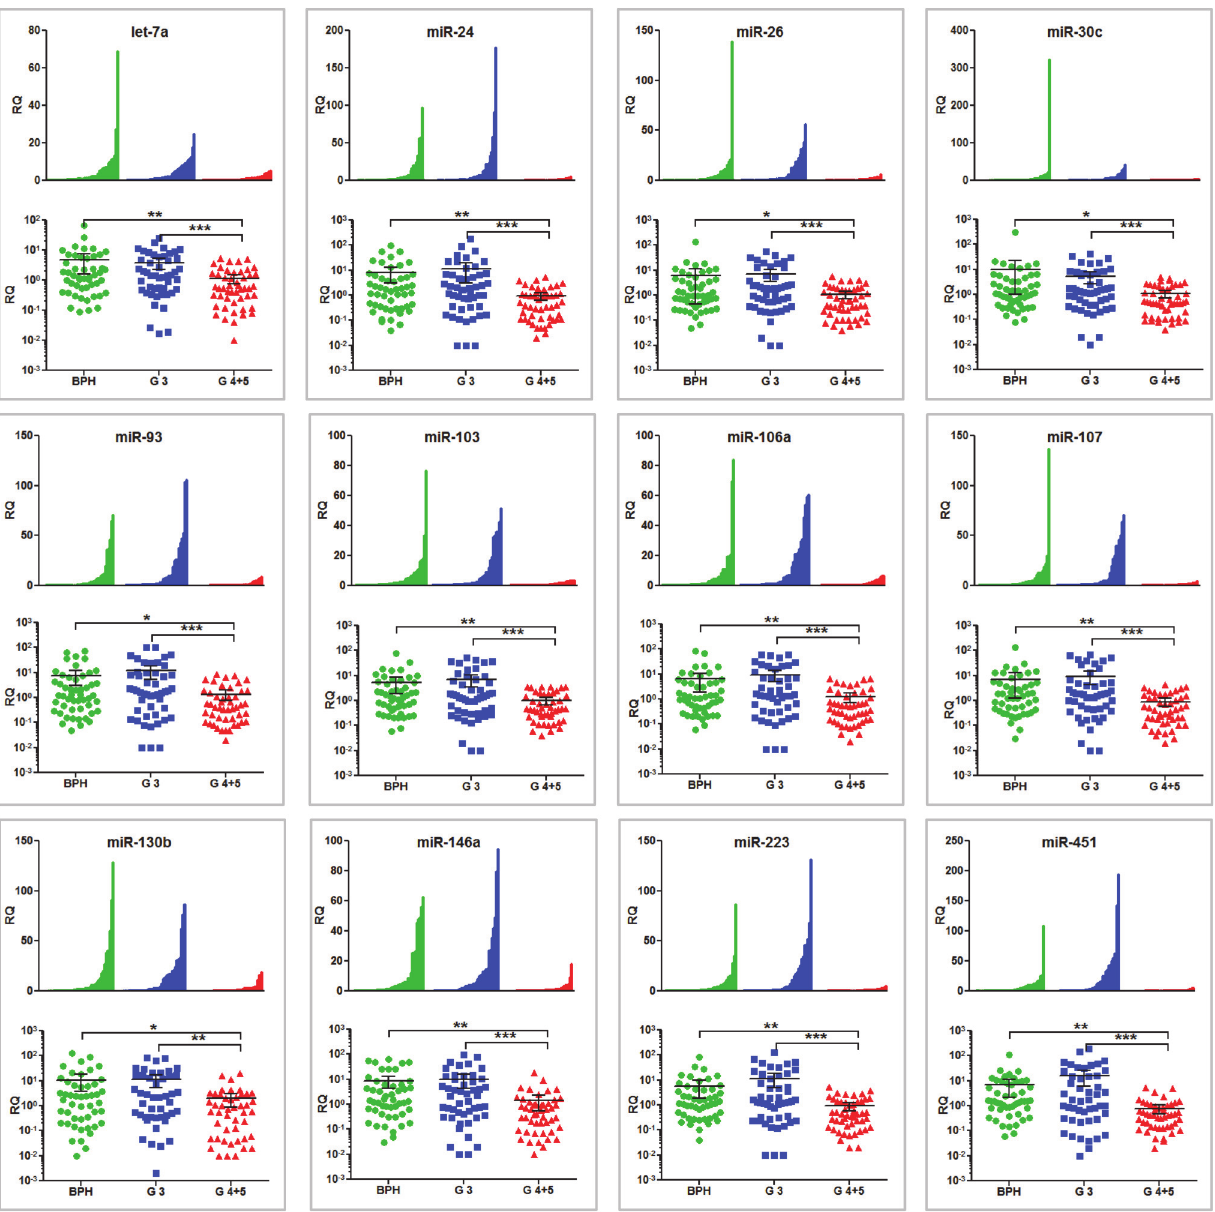
Fig 1. Circulating miRNAs levels in patients with BPH, low-grade PCa and high-grade PCa. Waterfall plots (linear y-axis) and scatter plots (log10 y- axis) of RQ values for all patients. In the waterfall plots each patient is shown as a vertical line on the x-axis and sorted by RQ within each group, for the top 12 miRNAs in the miR Score; let-7a, miR-24, 26a, 30c, 93, 103, 106a, 107, 130b, 146a, 223, and 451 and by disease. For the scatter plots the y-axis is shown log10 to improve visualization of low range RQs. BPH = benign prostate hyperplasia (N = 50). Gleason 3 = 100% of the tumor was Gleason grade 3 (N = 50). Gleason 4+5 = 30 – 90% of the tumor was Gleason 4 and/or 5 (N = 50). * p < 0.05, ** p < 0.01, *** p < 0.0001 by Kruskal – Wallis one-way analysis of variance with Dunn's multiple comparisons